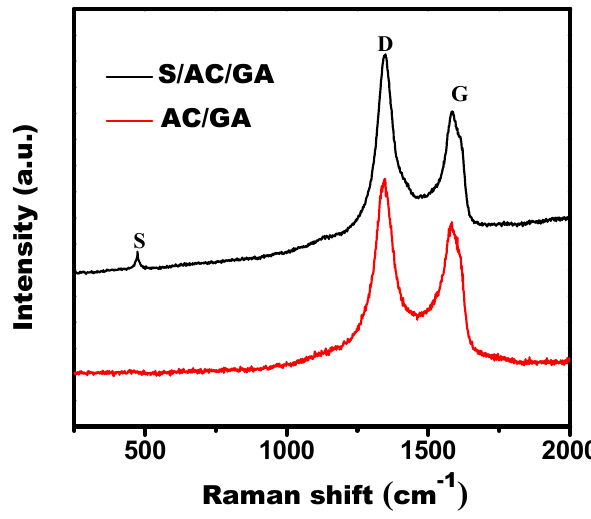
Figure 3. Raman spectra of AC/GA and S/AC/GA composites.